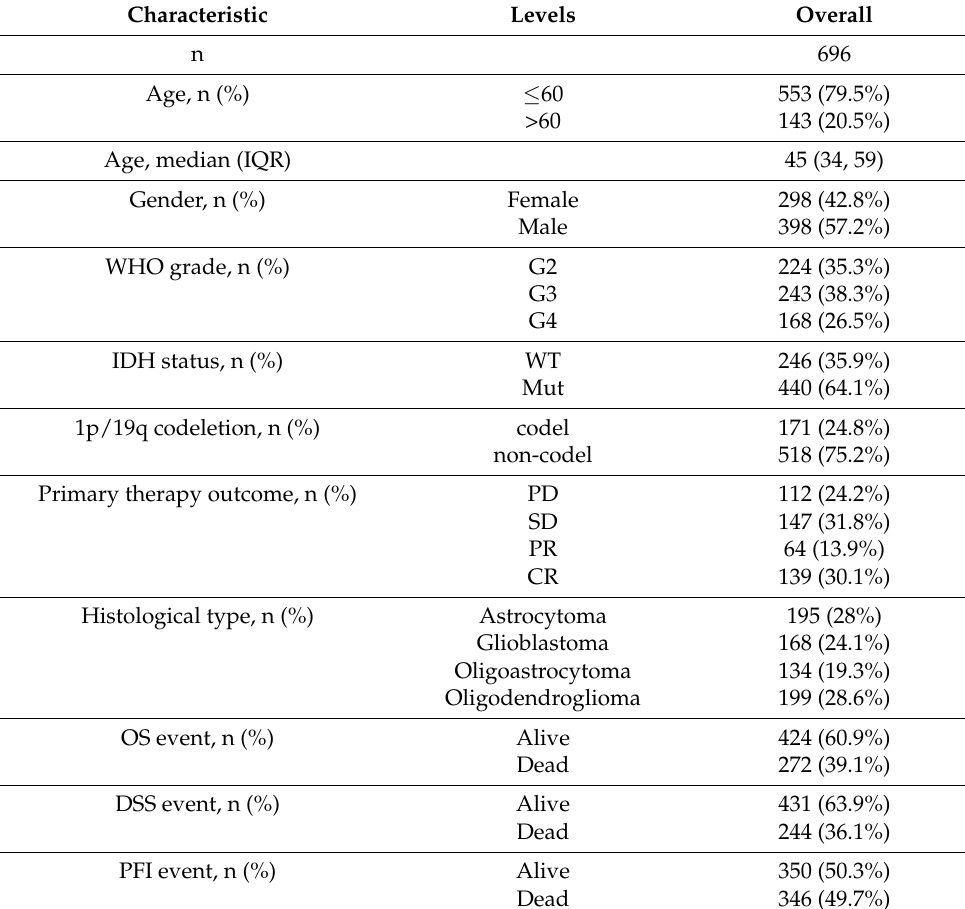
Table 1. Clinical characteristics of the glioma